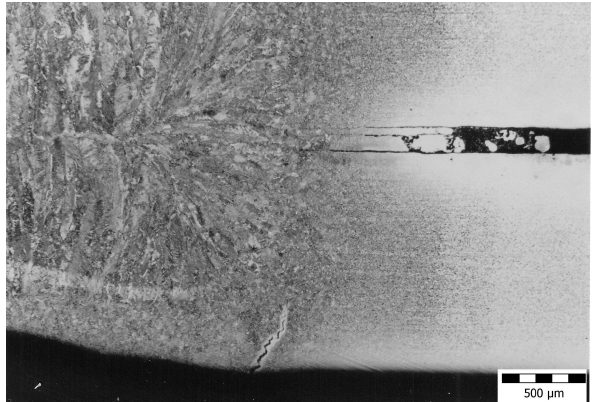
Figure 14: Cracks in heat affected zone of sample